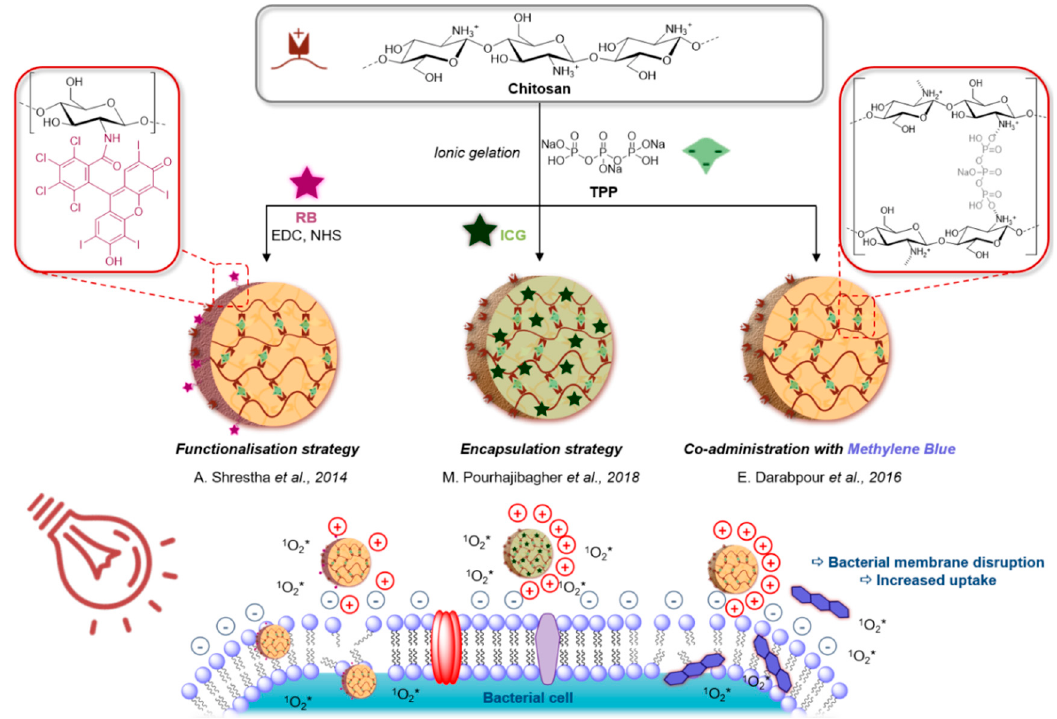
Figure 9. Examples of the preparation of chitosan nanoparticles (NPs) by ionic gelation for aPDT via covalent surface attachment [127], encapsulation [130] or co-adminisation, [126] of di ff erent